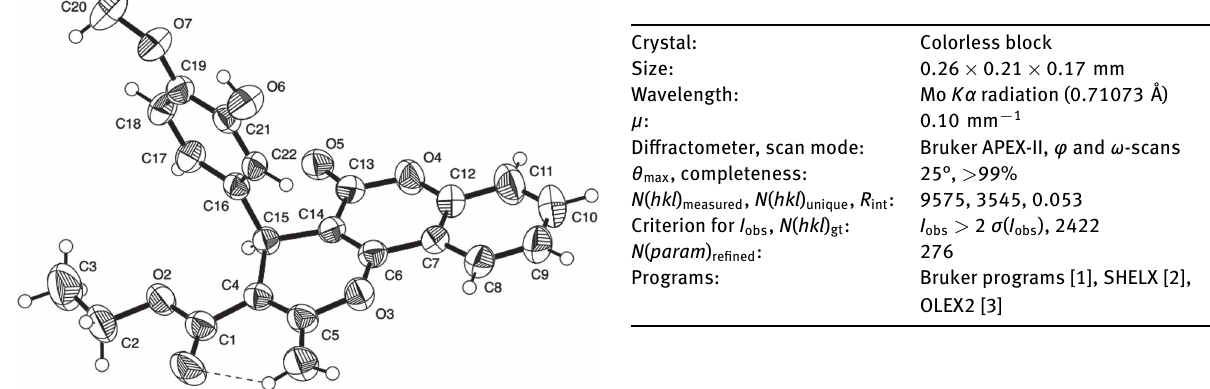
Table 1: Data collection and handling.